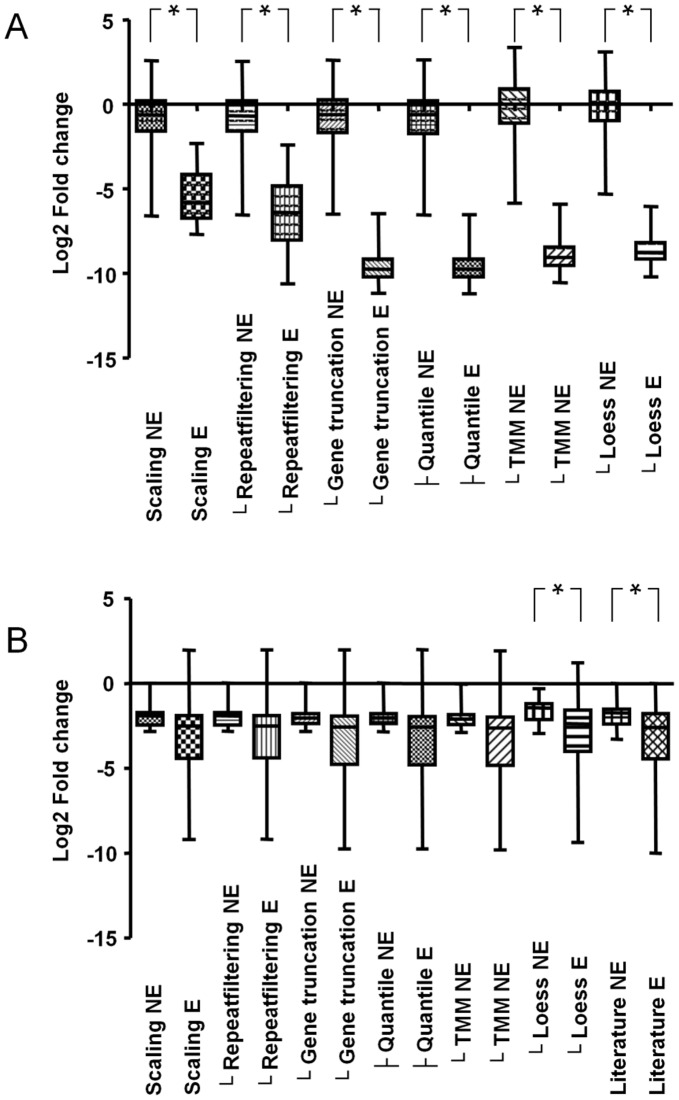
Box whisker plots of gene essentiality data.Box whisker plot showing the sample minimum, lower quartile, median, upper quartile, and sample maximum of (A) fold change data of essential (E) and nonessential (NE) genes for growth of S. pneumoniae and (B) fold change data of essential (E) and nonessential (NE) genes for tobramycin resistance of P. aeruginosa PAO1 as calculated by ESSENTIALS after the various processing steps and in the case of P. aeruginosa PAO1 also for the fold change data presented by Gallagher et al.
[10]. Significant difference between the essential and non-essential gene distributions is shown by *(p<0.01).